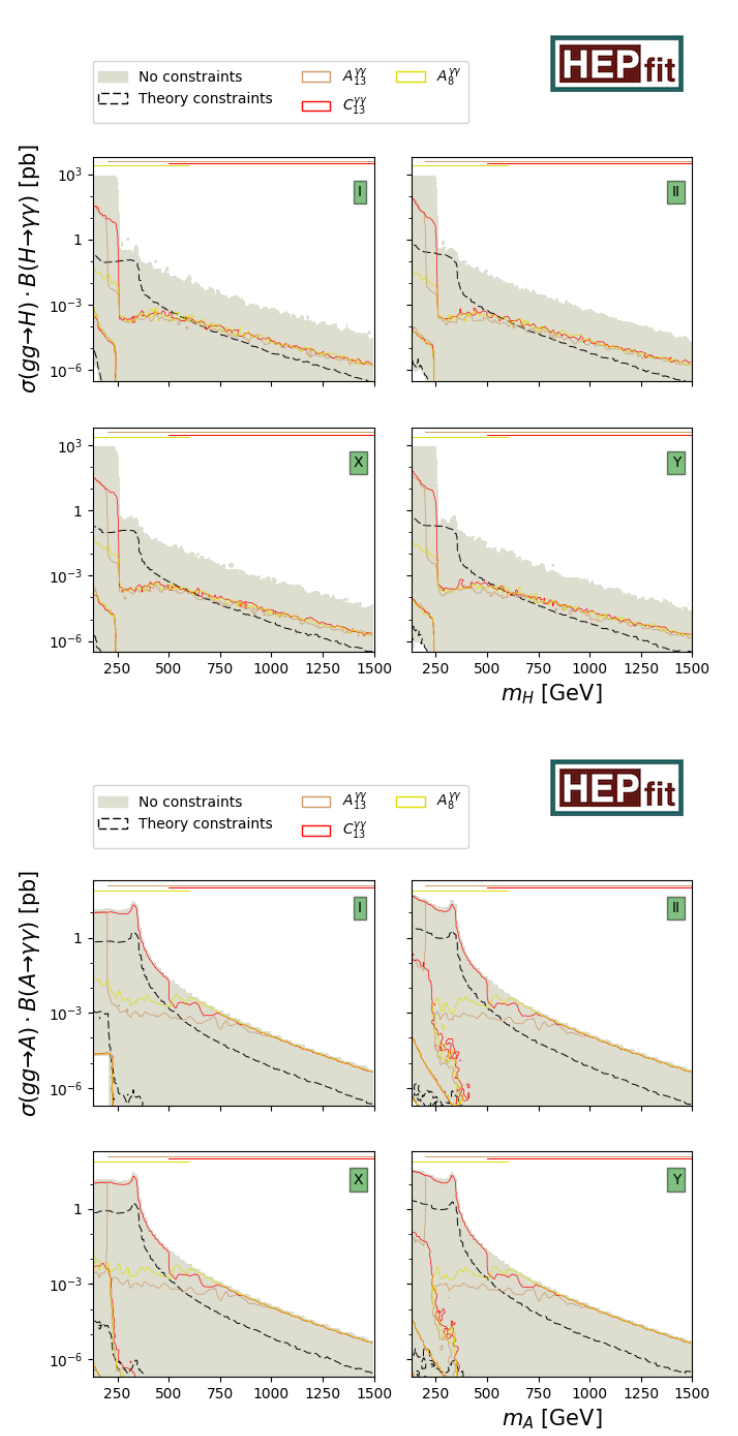
Figure 8 . 95% contours of the single searches for H=A ! (cid:13)(cid:13) in the (cid:27) (cid:1) B vs. m four 2HDM types (top: H , bottom: A ). For details, see text.